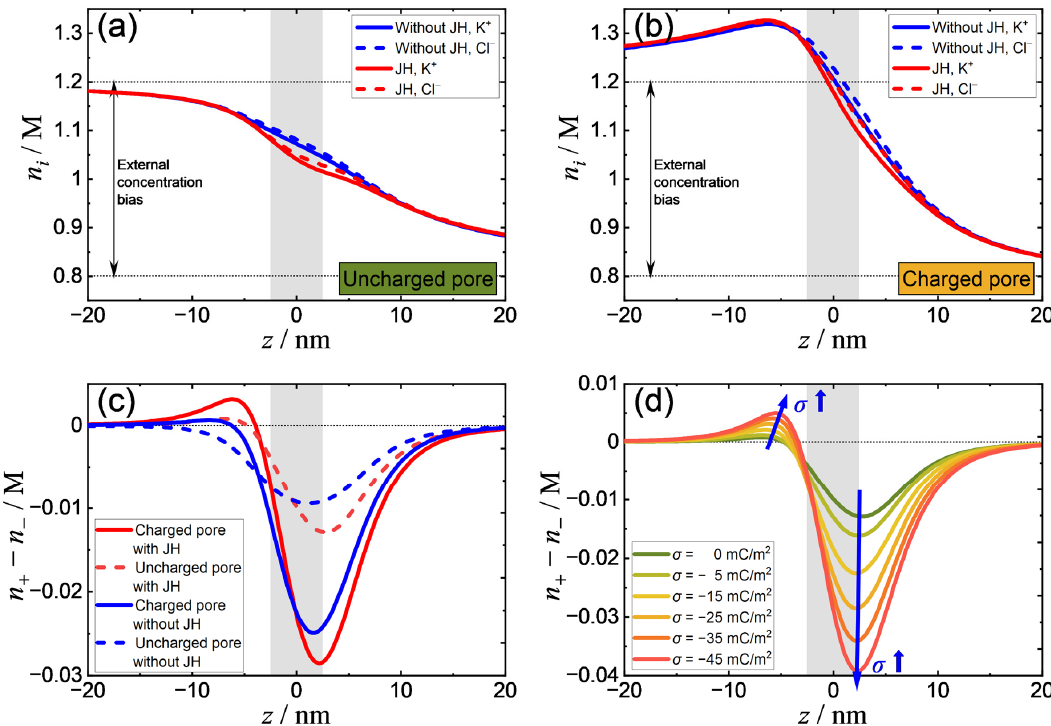
Figure 3. ( a ) Ion concentration distribution of cation and anion in an uncharged nanopore with / without Joule heating; ( b ) ion concentration distribution of cation and anion in a negatively charged nanopore with / without Joule heating, where σ = − 25 mC · m − 2 ; ( c ) induced charge concentration in four di ff erent cases: Uncharged / negatively charged nanopore with / without Joule heating e ff ects; ( d ) e ff ect of surface charge density on transport-induced-charge (TIC). (The “JH” in the legend denotes Joule